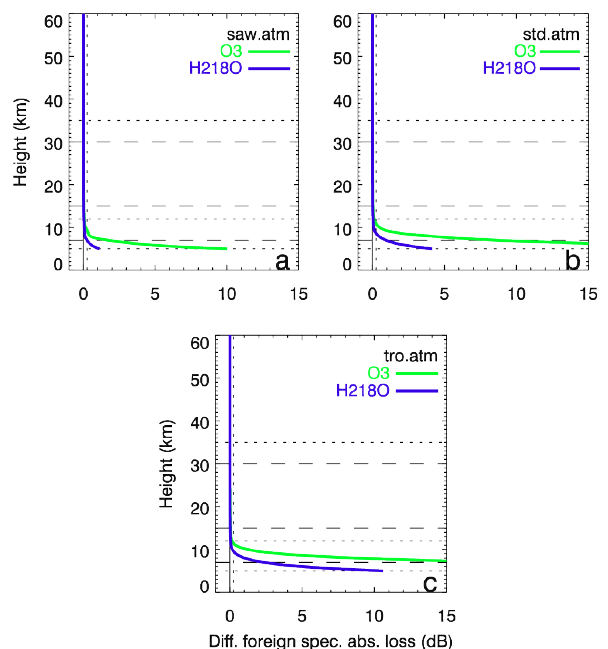
Fig. 6. Differential foreign species absorption loss for channel pairs with significant sensitivity of foreign species loss to atmospheric conditions. The losses are shown in the FASCODE SAW (a) , STD (b) , and TRO (c) atmospheres. The layout is the same as in Fig. 5.